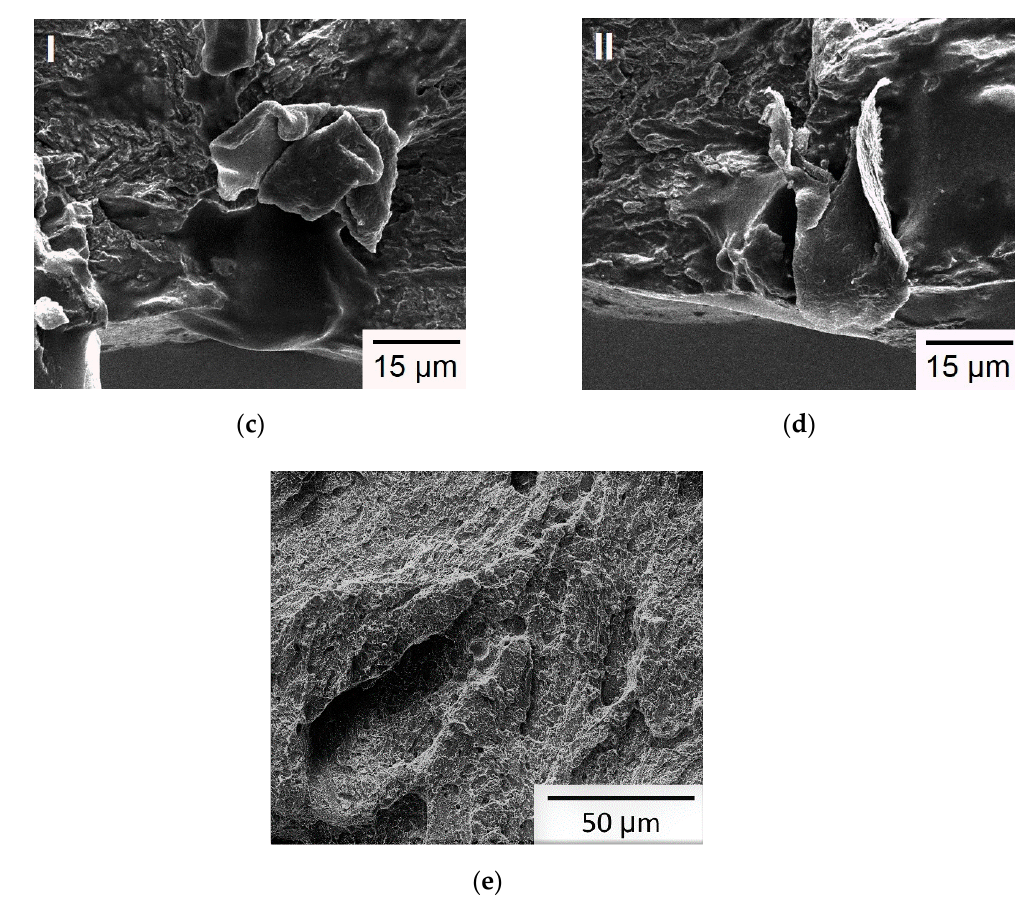
Figure 6. SEM micrographs of a Group A specimen: ( a ) Overview of fracture surface; ( b ) high-magnification view of the outlined fracture origin zone in ( a ); ( c ) defect I in ( b ); ( d ) defect II in ( b ); ( e ) high-magnification view of a region away from the fracture origin.